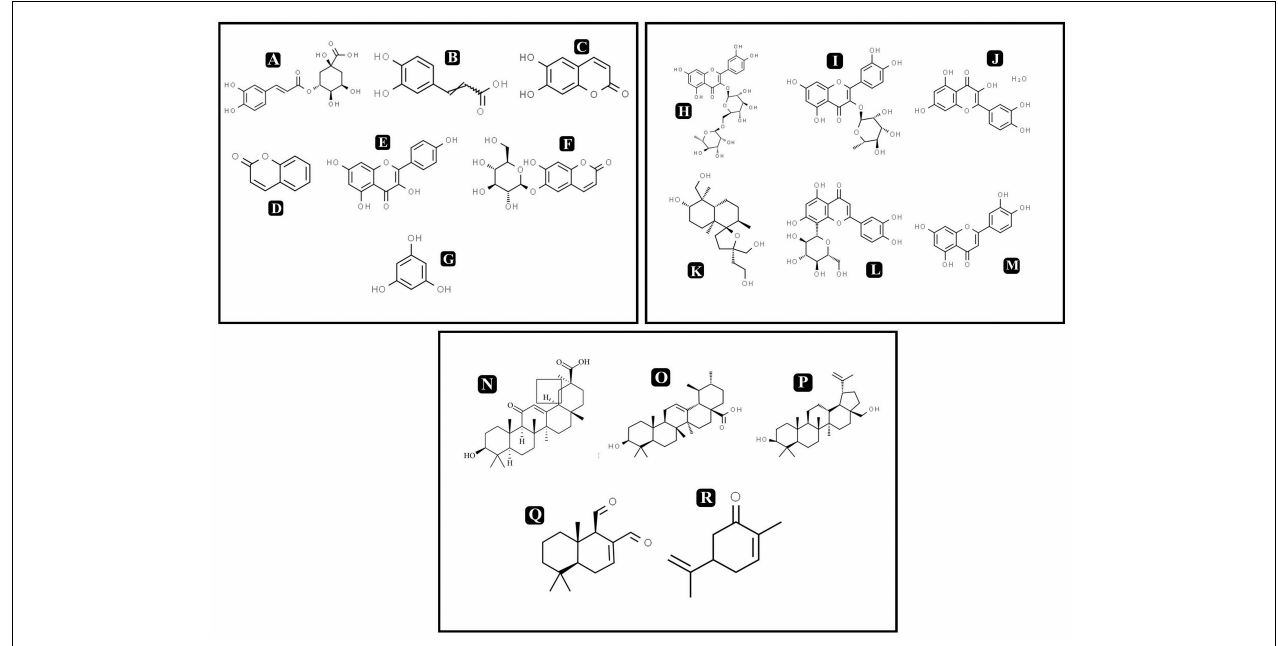
FIGURE 9 | Chemical structures of identified compounds by HR-LCMS (A) chlorogenic acid, (B) caffieic acid, (C) esculetin, (D) coumarin, (E) kaempferol, (F) chlorogenic acid, phloroglucinol, (G) esculin, (H) rutin, (I) quercitrin, (J) quercetin, (K) lagochilin, (L) orientin, (M) luteolin, (N) 18- β -glycyrrhetinic acid, (O) ursolic acid, (P) betulin, (Q) carvone, and (R) polygodial.